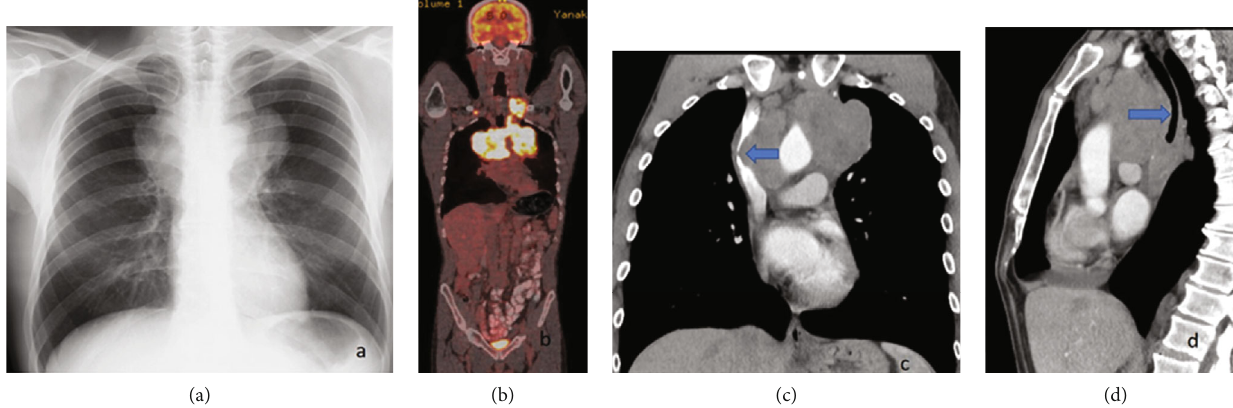
Figure 1: FDG avid lymph nodes in the left supraclavicular region extending to the anterior mediastinum.